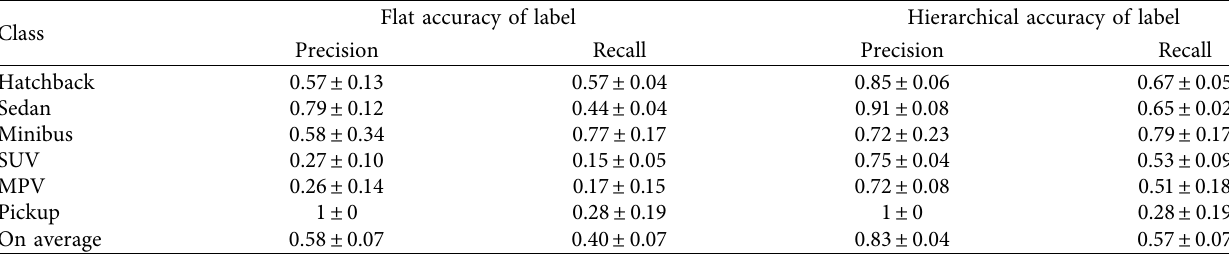
Table 3: Annotation accuracy of ground truth annotations for the downsampled UTS dataset.